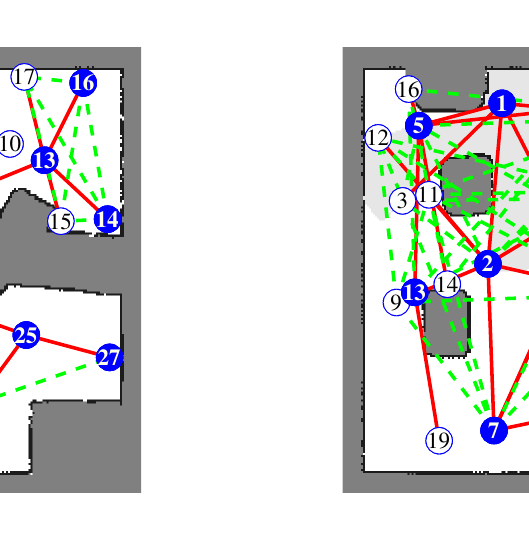
Figure 8. Resulting frontier-graph structure on the final grid map by the BFS exploration. The number is the ID of each frontier node. Red lines are edges between the parent and child nodes. Dotted green lines are edges between sibling nodes. Blue circles are active nodes, and white circles are inactive nodes: ( a ) Frontier-graph from 4 m LRF. ( b ) Frontier-graph from 8 m LRF.